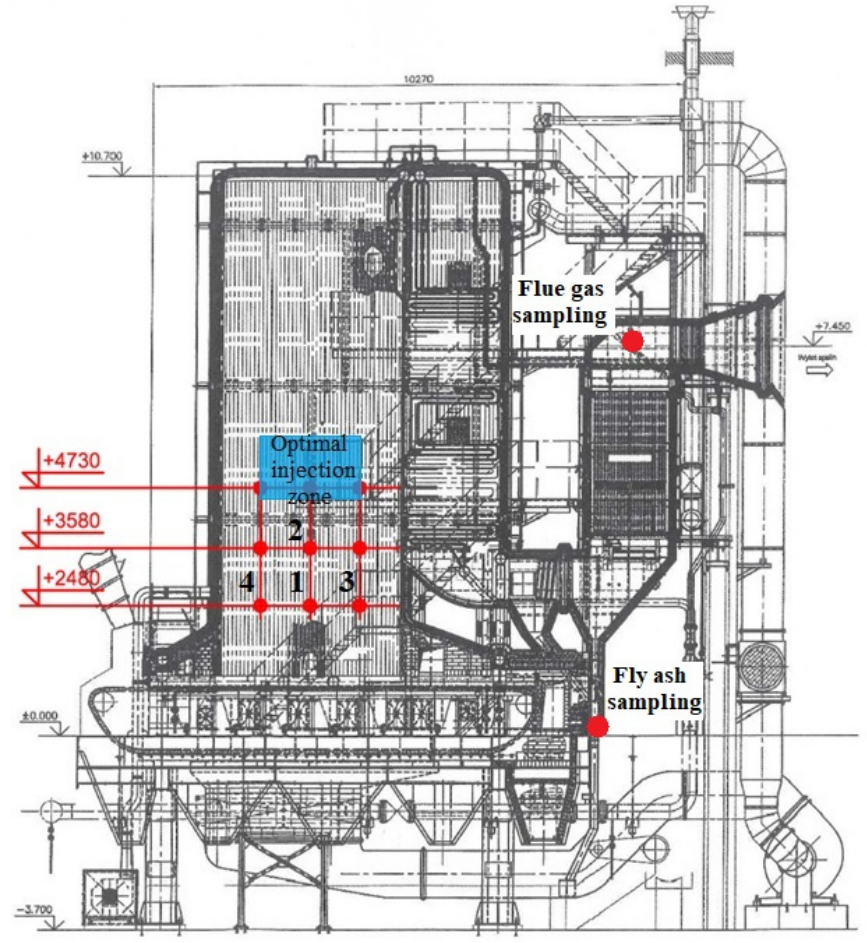
Figure 1. Stoker boiler WR-25 with sorbent injection and in-furnace temperature measurement